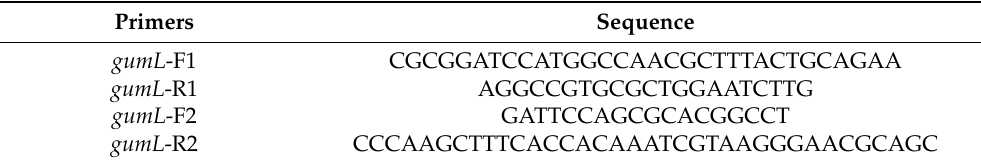
Table 1. Primers used in this study. Primers Sequence gumL